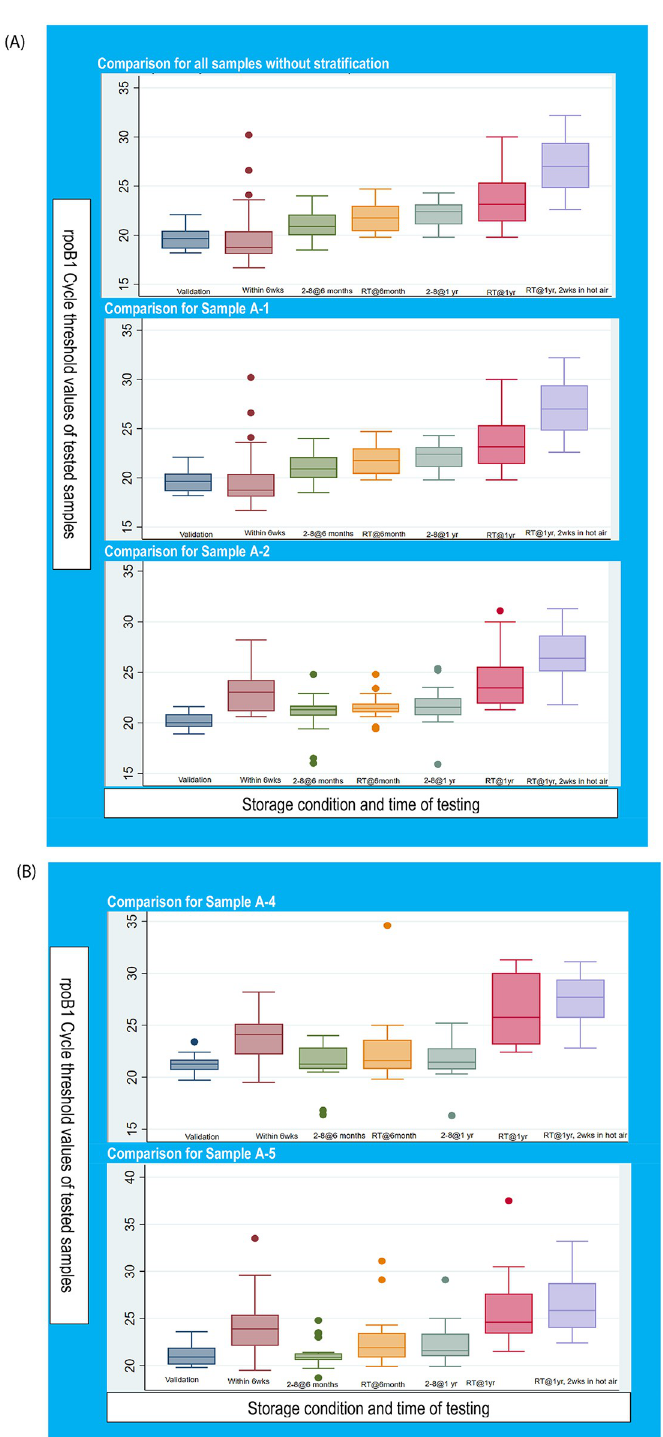
Fig 1. Boxplot of rpoB1 Ct values of DTS tested at the different temperatures and periods.